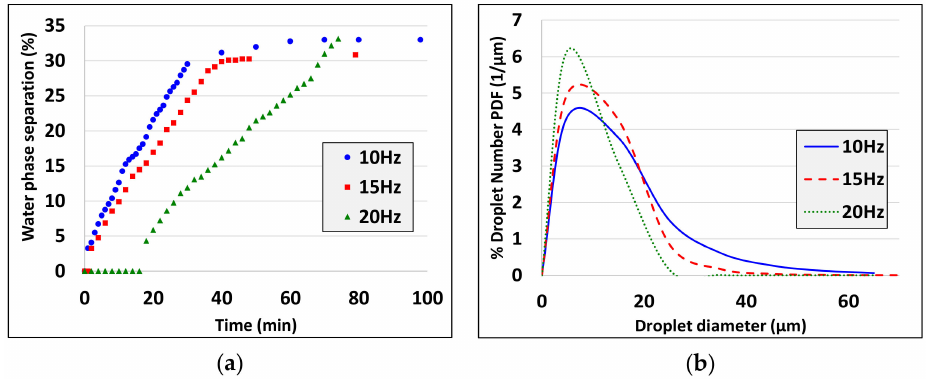
Figure 13. E ff ect of stroke frequency f on ( a ) water phase separation and ( b ) droplet size distribution of emulsions (C SDS = 1 CMC, ϕ = 0.5 and t n = 2 min; Piston 2, 10 Hz: d av = 14.4 µ m, 15 Hz: d av = 10.1 µ m,